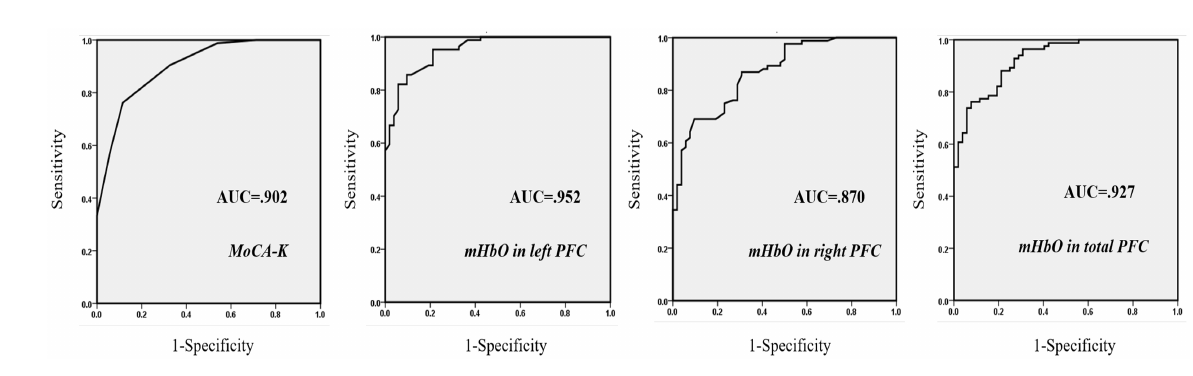
FIGURE 3 ROC curves of three predictors. Greater AUC values indicate higher power in discriminating MCI from healthy subjects.